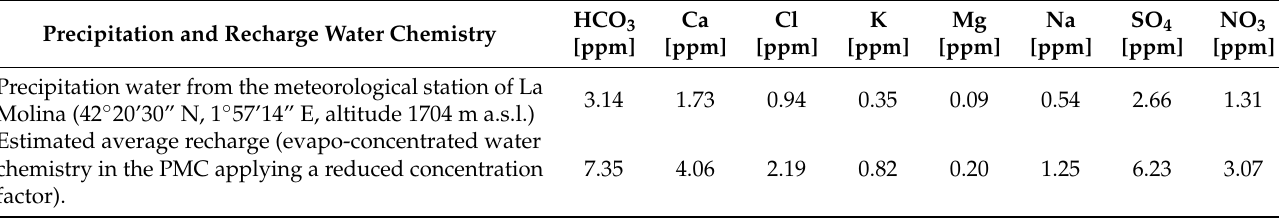
Table A5. Hydrochemical composition of precipitation [62] and the estimated average recharge evapo-concentrated water chemistry in the PMC applying a concentration factor as estimated by Herms et al. (2019) [29].